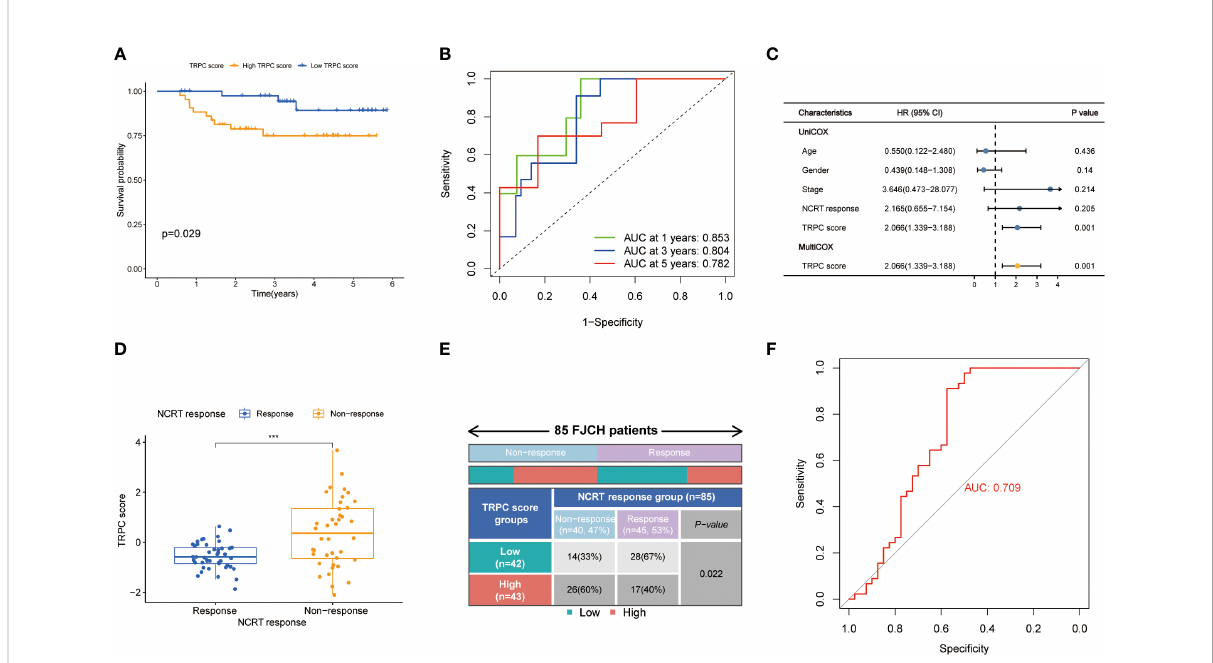
FIGURE 9 Validation of TRPC score in the Fujian Cancer Hospital cohort. Kaplan-Meier curve (A) , 1-year, 2-year, and 3-year ROC curves (B) and univariate and multivariate Cox regression analysis (C) according to the TRPC score. The scatter diagram of the TRPC score between response and non- response group (D) , and fourfold table between TRPC score and NCRT response (E) . (F) ROC curve of TRPC score to predict NCRT response. NCRT, neoadjuvant chemoradiotherapy; ROC, receiver operator characteristic; TRPC, transient receptor potential channels; ***P<